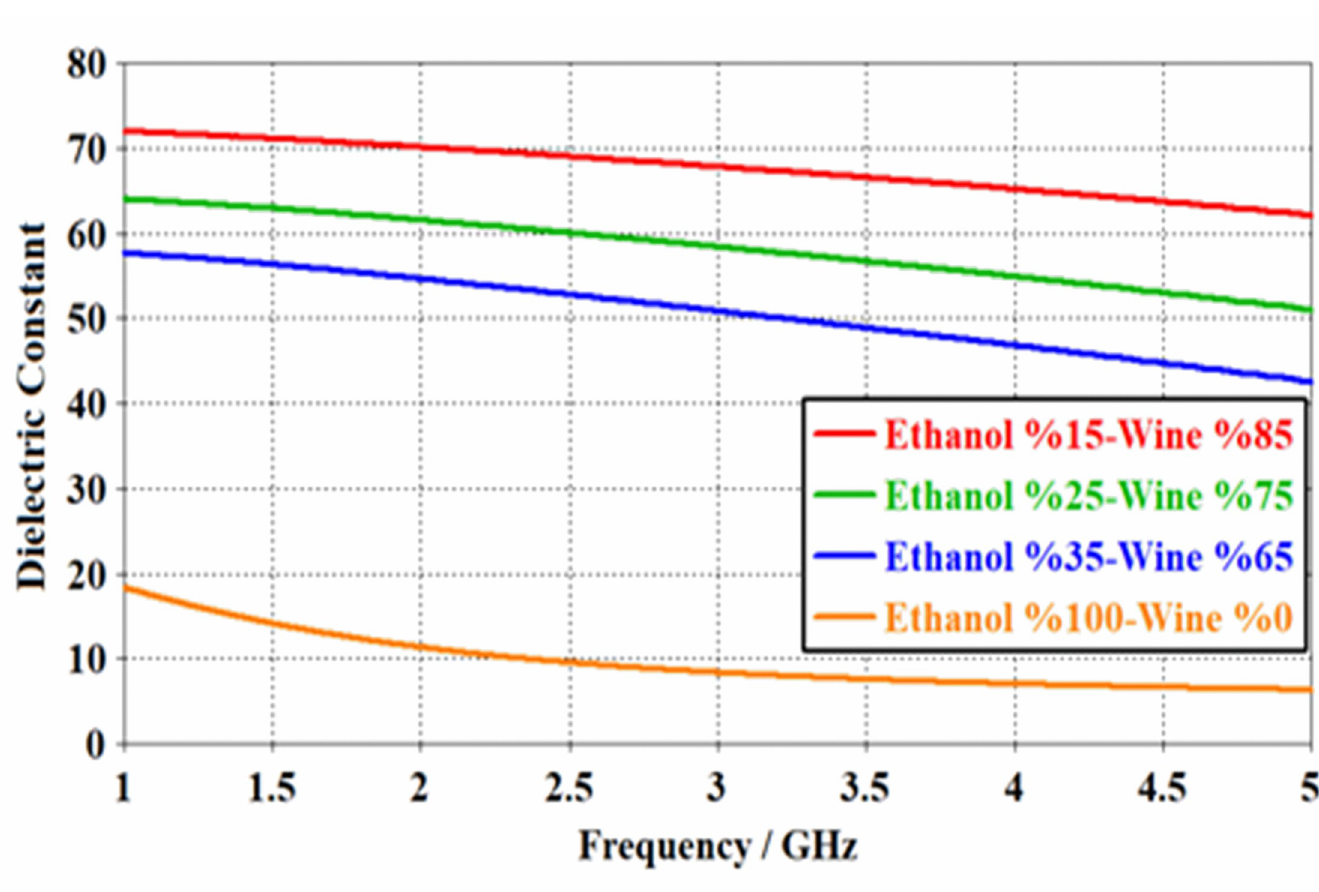
Fig 3. Dielectric values for different contents of wine-ethanol in the frequency range from 1 to 5 GHz.